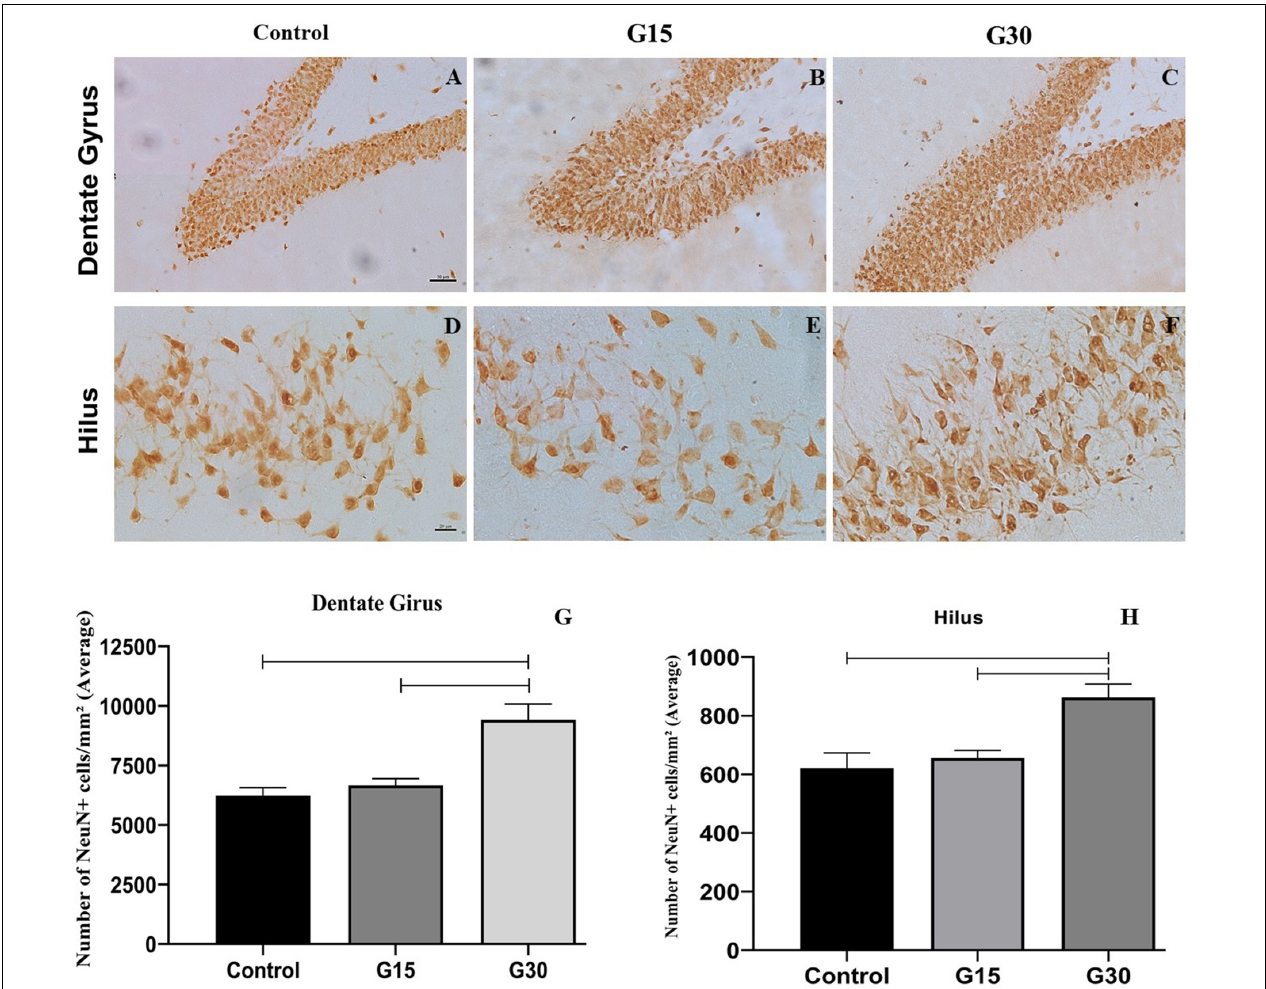
FIGURE 4 | Compensatory increase in the number of NeuN+ cells in the hippocampal dentate gyrus following unilateral hippocampectomy. Immunolabeling for NeuN in coronal sections from animals belonging to all experimental groups (control, G15, and G30). There was an increase in the number of NeuN+ cells in both dentate gyrus (A–C) and hilus (D–F) at G30 compared to control (A,D) . This has been confirmed by the quantitative analysis [ (G,H) Kruskal–Wallis with Dunn’s post hoc test (dentate gyrus); one-way ANOVA with Tukey’s posttest test (hilus), p < 0.01]. Scale bars: (A–F) 50 mm.